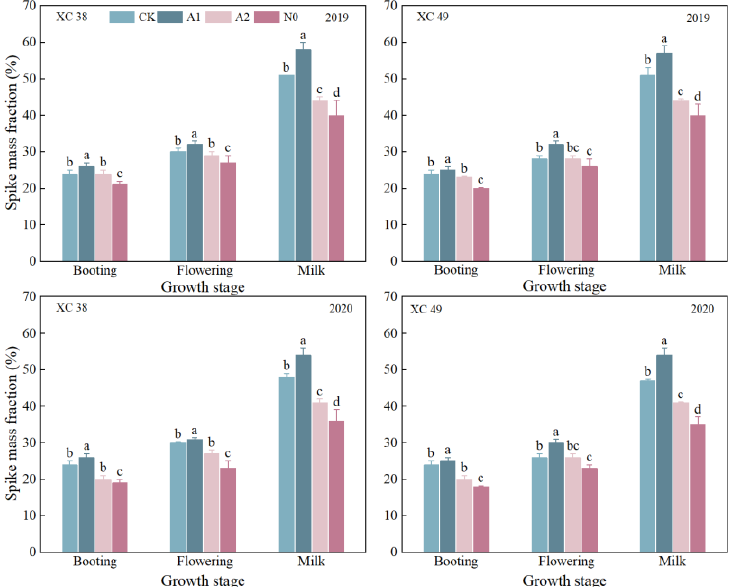
Figure 6. Effect of nitrogen reduction treatments on the spike mass fraction in drip-irrigated spring wheat. Note: spike mass fraction = spike dry mass/shoot dry mass. XC 38: Xinchun 38; XC 49: Xin- chun 49. Nck: 300 kg·ha −1 ; N0: 0 kg·ha −1 ; A1: 240 kg·ha −1 ; A2: 210 kg·ha −1 . V: variety, N: different